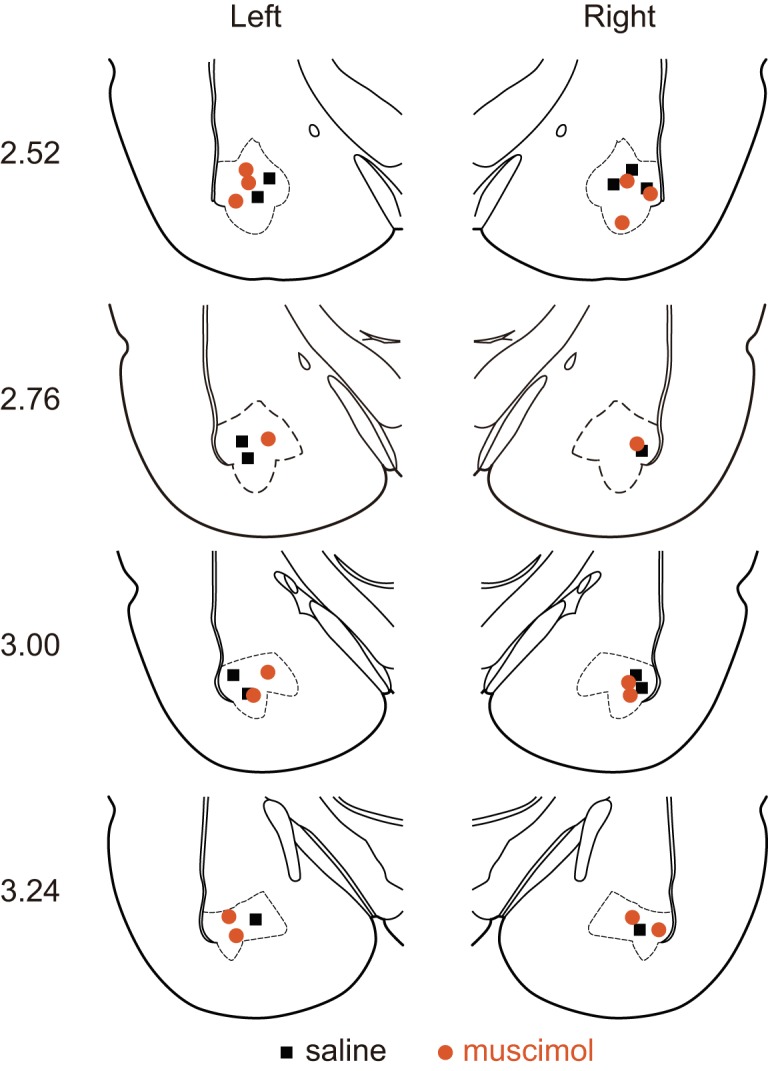
Histologic findings. The locations of the injection cannulae tips were reconstructed based on the Paxinos and Watson brain atlas (Paxinos and Watson, 2007). Orange circles, muscimol-injected rats; black squares, saline-injected rats.